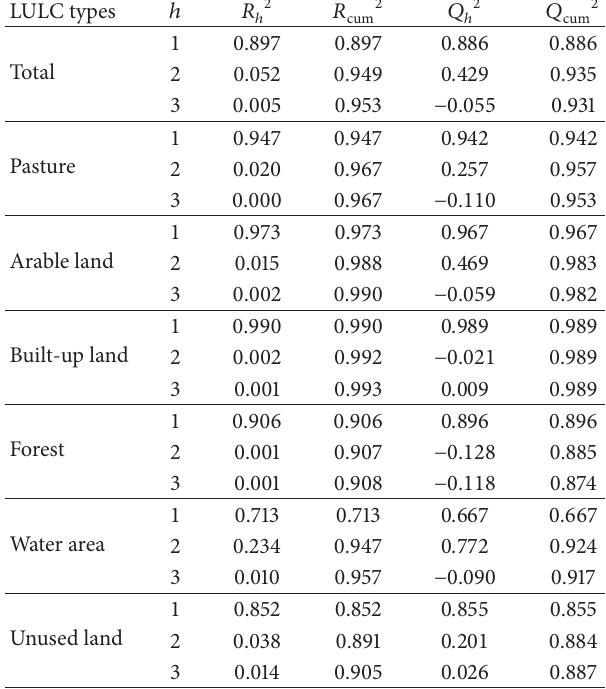
Table 1: Values of parameters under Leave-One-Out Cross Valida- tion